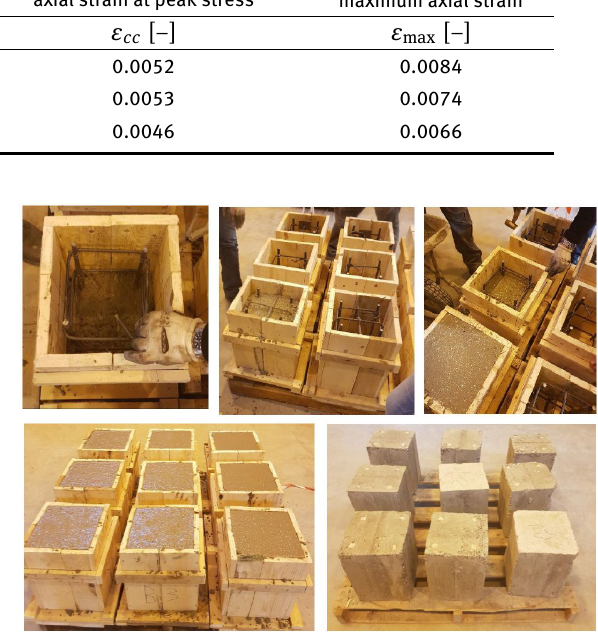
Figure 5: Specimen preparation phases, in chronological order from top left to bottom right, of concrete columns with different arrangements of transverse